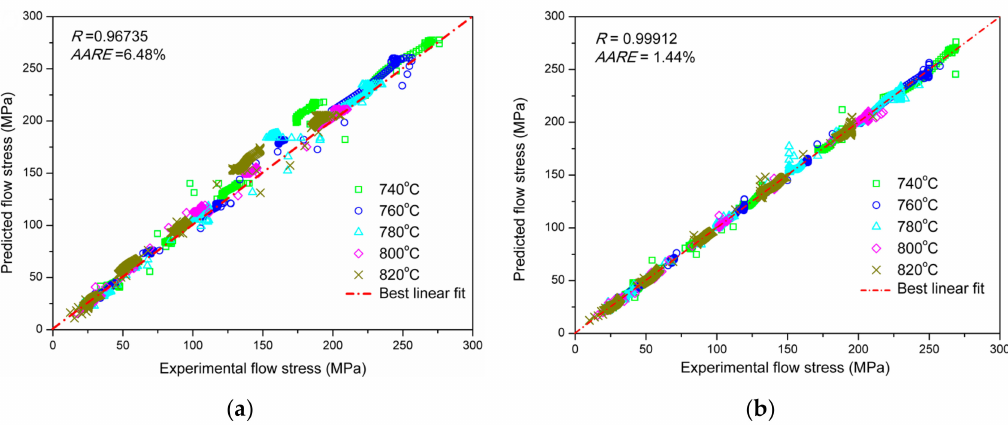
Figure 12. Correlations between the experimental flow stress and the predicted flow stress obtained from the ( a ) OC model and ( b ) MC model under all deformation